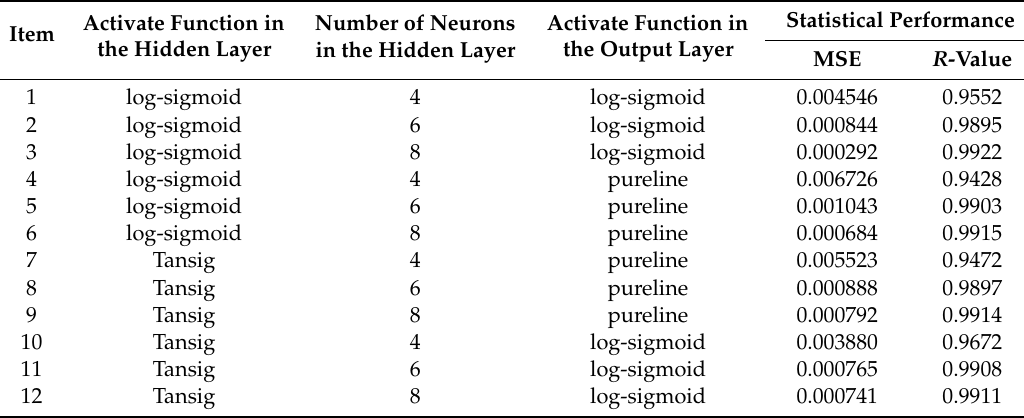
Table 3. Optimization of Artificial Neural Network (ANN)